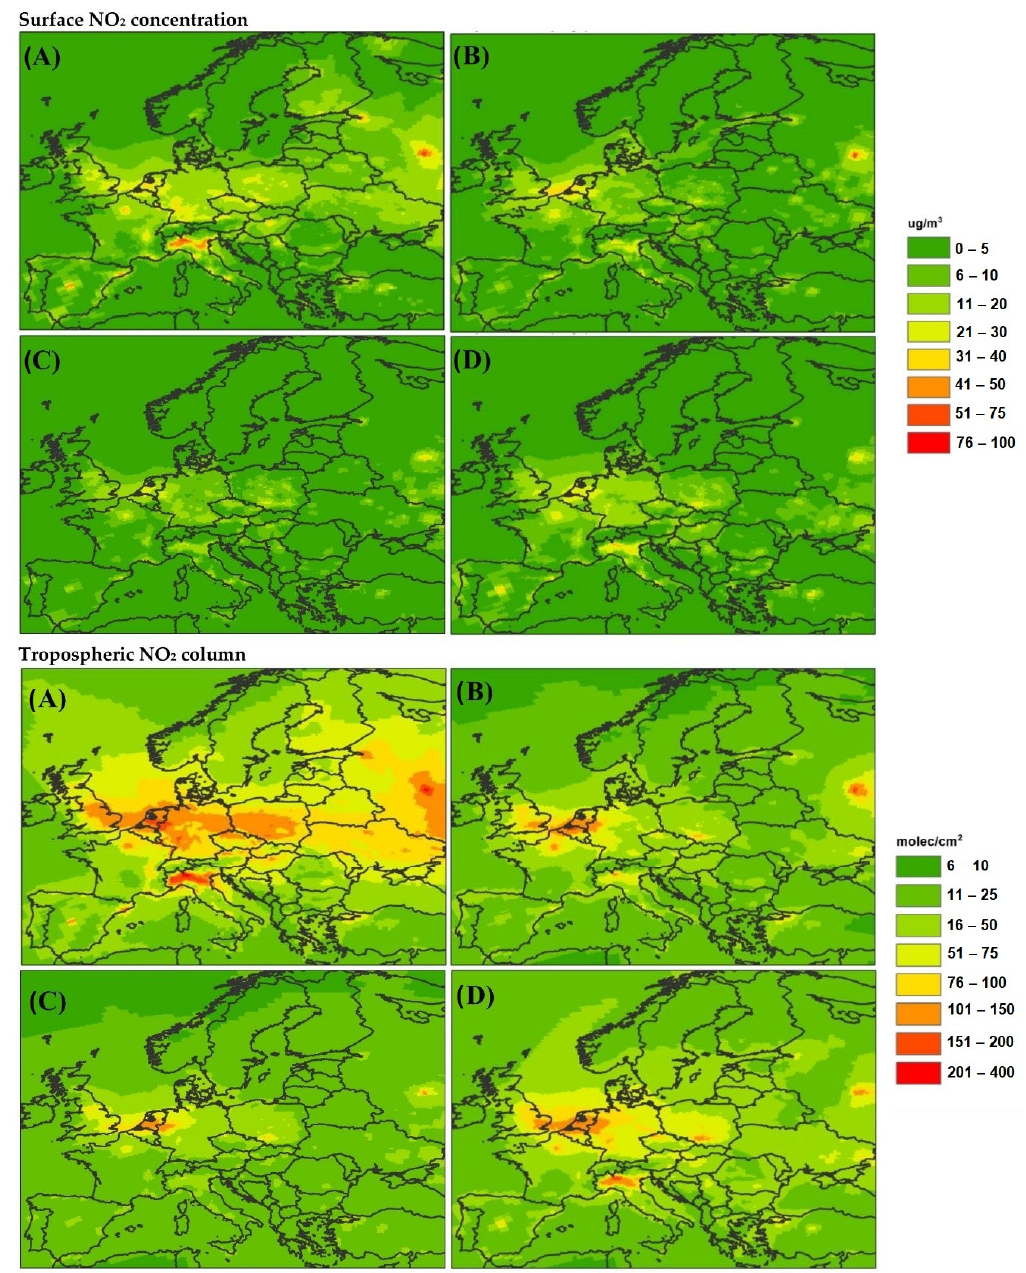
Figure 10. Surface NO 2 concentration fields (top panel) and tropospheric NO 2 column (bottom panel) for 2010 were calculated for a selected month by the GEM-AQ. ( A ) February, ( B ) April, ( C ) August, ( D ) October. The relationship between the modelled surface NO 2 concentrations and the value of the modelled tropospheric NO 2 column is shown in Figure 11. A similar high correlation (>0.5) between OMI observations and ground-based in situ measurements was also recorded in important European Cities during 2005–2014 [40].